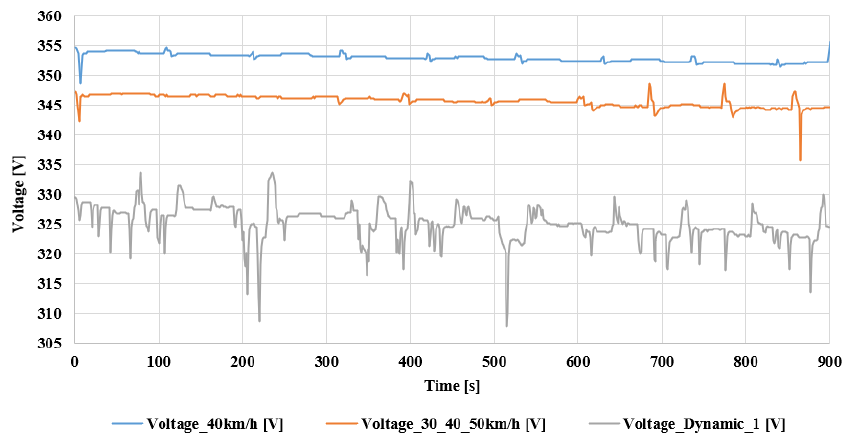
Figure 5. The voltage of the e-golf system under different loads.